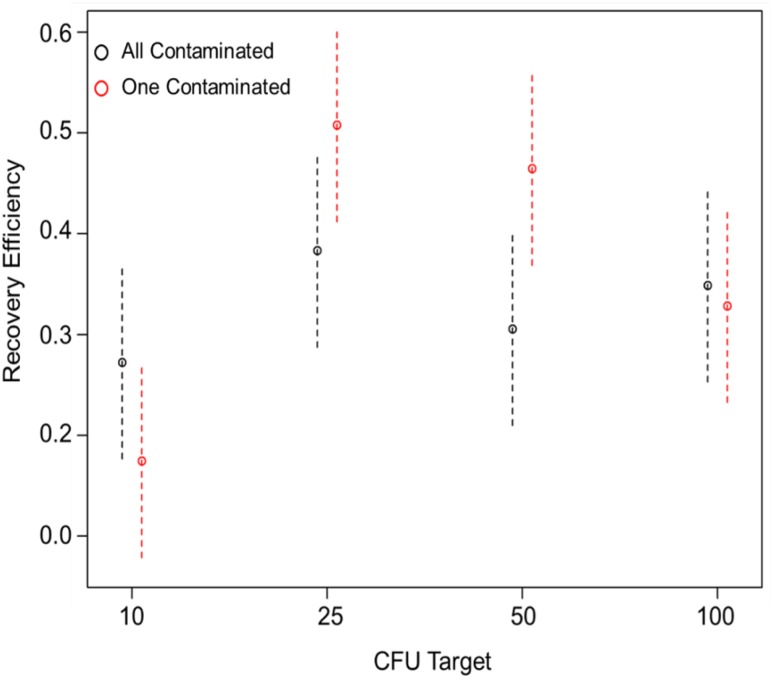
The interaction of two experimental factors, CFU target and number of contaminated locations, significantly affect recovery efficiency (p = 0.0271).The means are plotted as open circles and the error bars are representative of two standard deviations.